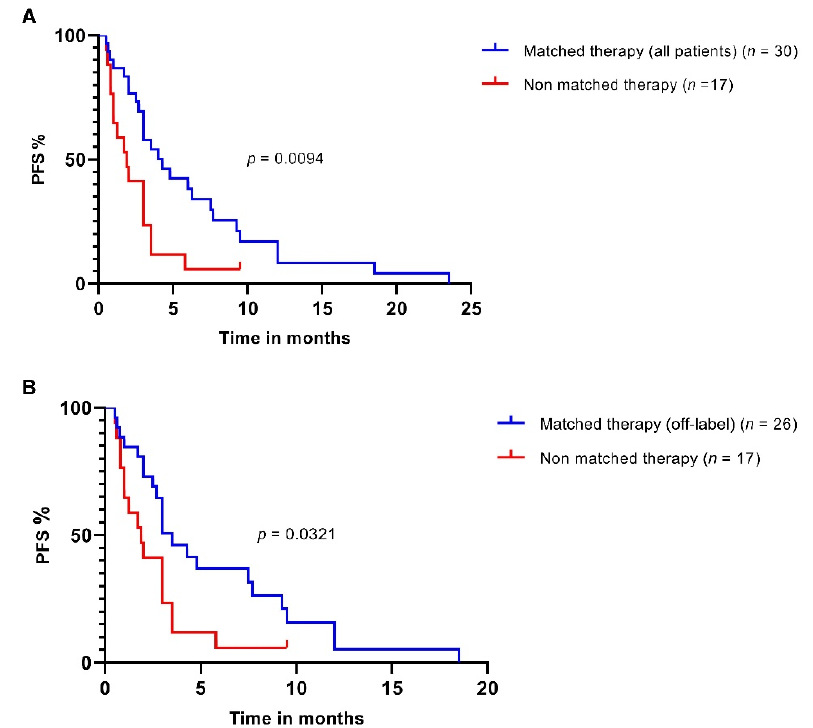
Figure 4. Outcome of patients after molecular profiling and discussion of cases by the MTB. ( A ) PFS of patients treated according to MTB recommendation (all patients, n = 30) compared to patients receiving other systemic treatment ( n = 17). ( B ) PFS of patients treated by off-label regimens according to MTB recommendation ( n = 26) vs. patients receiving other systemic treatment ( n = 17). p -values were calculated with a log-rank test.